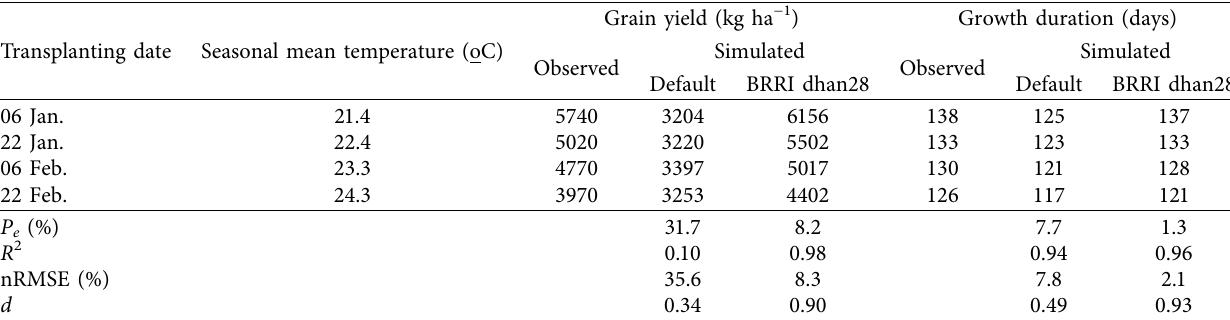
Table 5: Statistical evaluation of observed and simulated yield and growth duration of BRRI dhan28 for different transplanting dates during 2014-15 at Gazipur for model calibration.